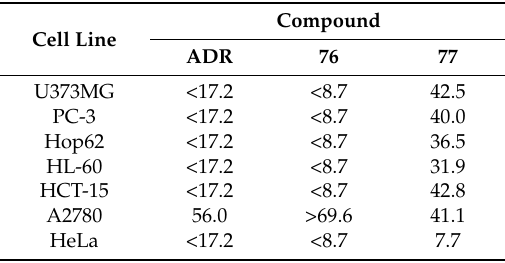
Table 17. Cytotoxicity data of 76 and 77 1